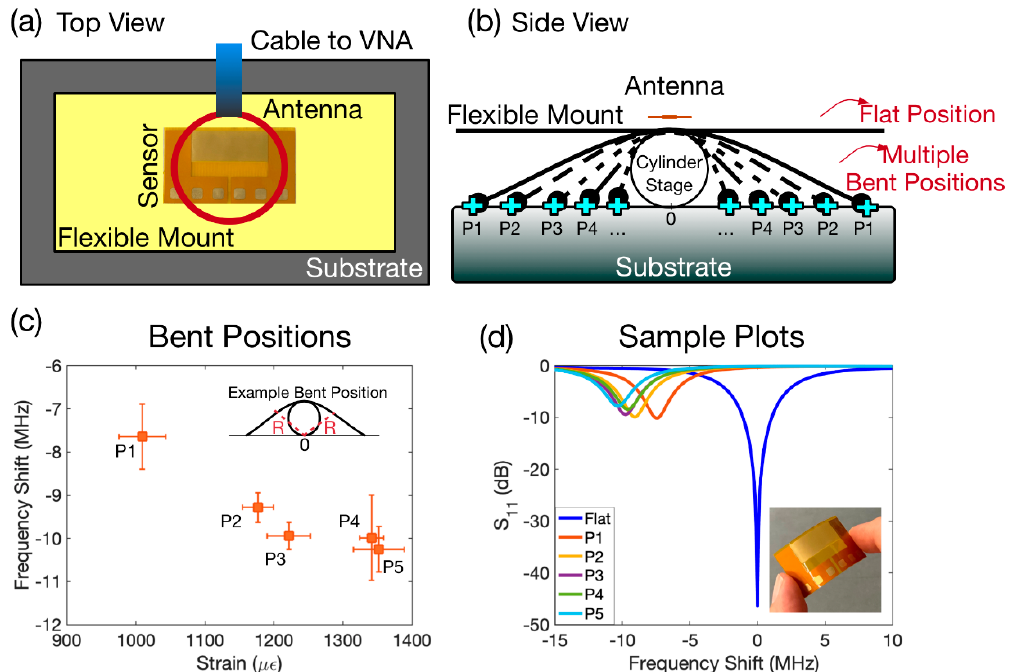
Figure 4. ( a ) Schematic of the experimental setup from top view. ( b ) Schematic of the experimental setup from side view. ( c ) Average nominal strain and frequency shift with respect to the flat position. The radius of curvature as an example of a bent position is illustrated in the inset. ( d ) Sample S 11 spectra of each position. spectra of each